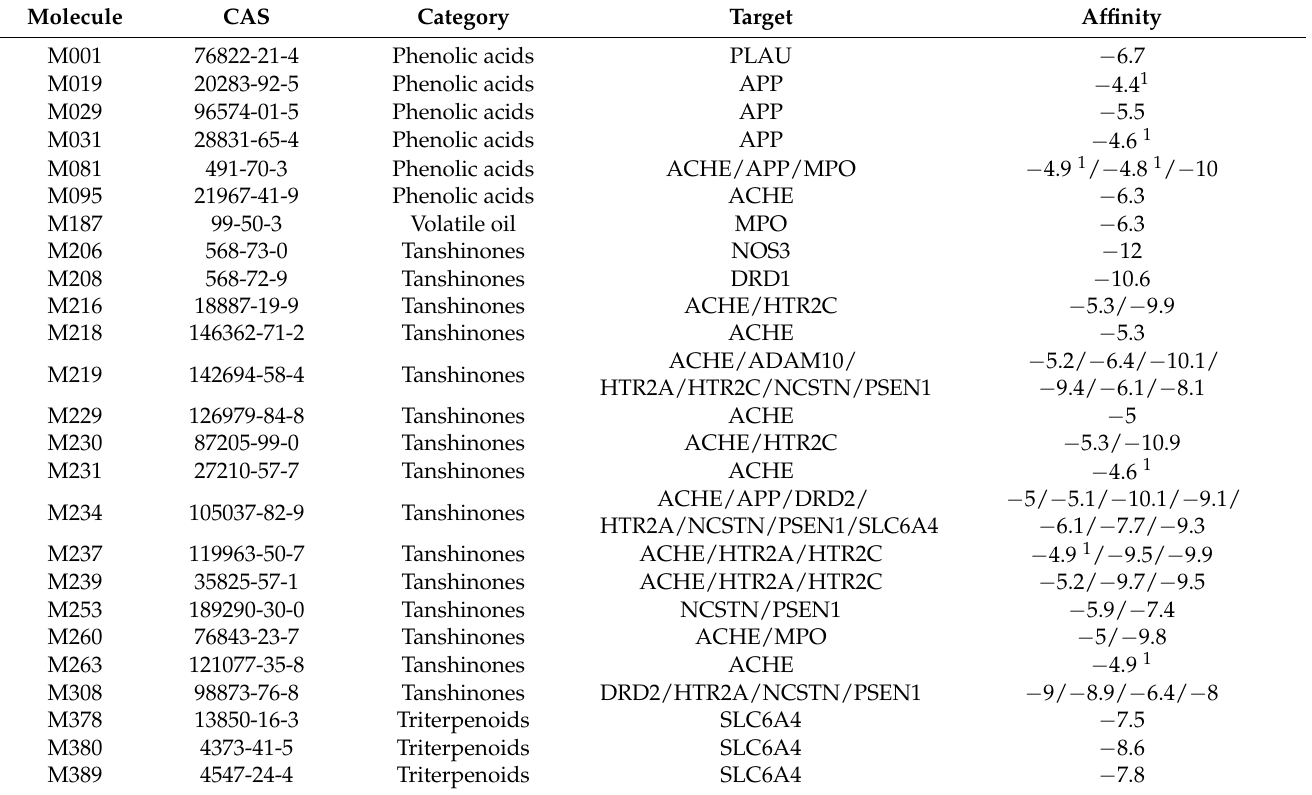
Table 1. In Silico Molecular docking of the anti-AD compound from